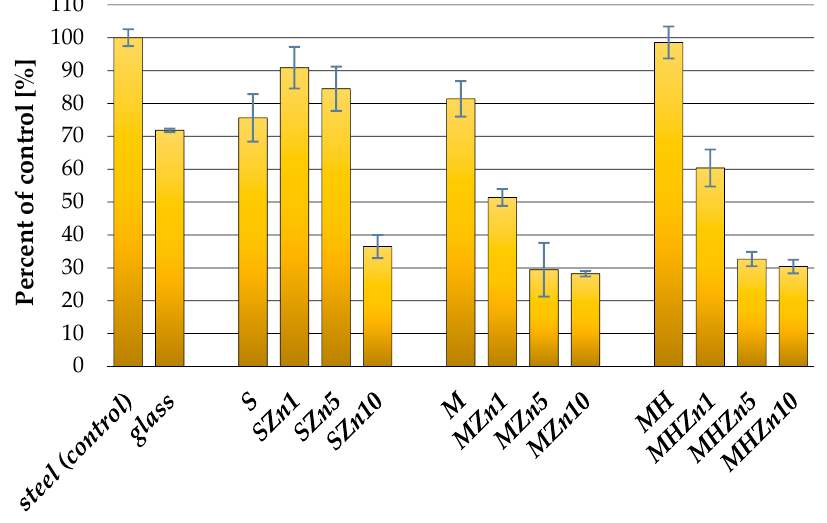
Figure 7. The colonization of bacteria on tested surfaces.